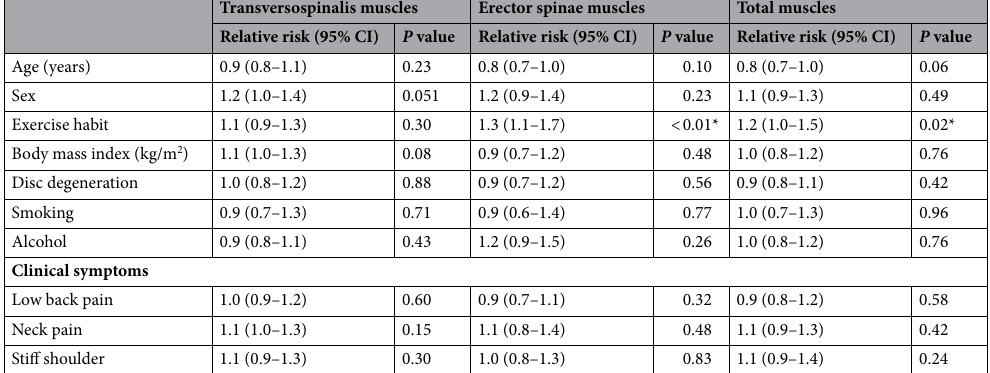
Table 2. Univariate association between changes in CSA over ten years and factors tested in the Poisson regression model. Asterisks indicate statistical significance. 95% CI, 95% confidence interval.